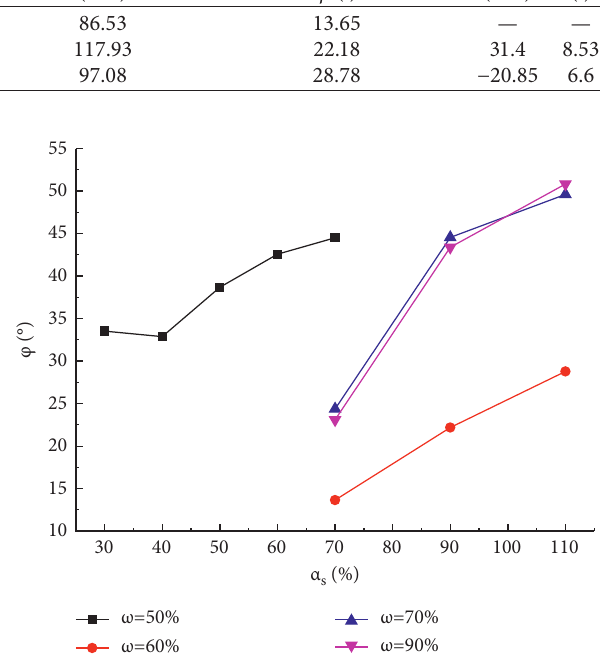
Figure 15: Curve of the internal friction angle of the